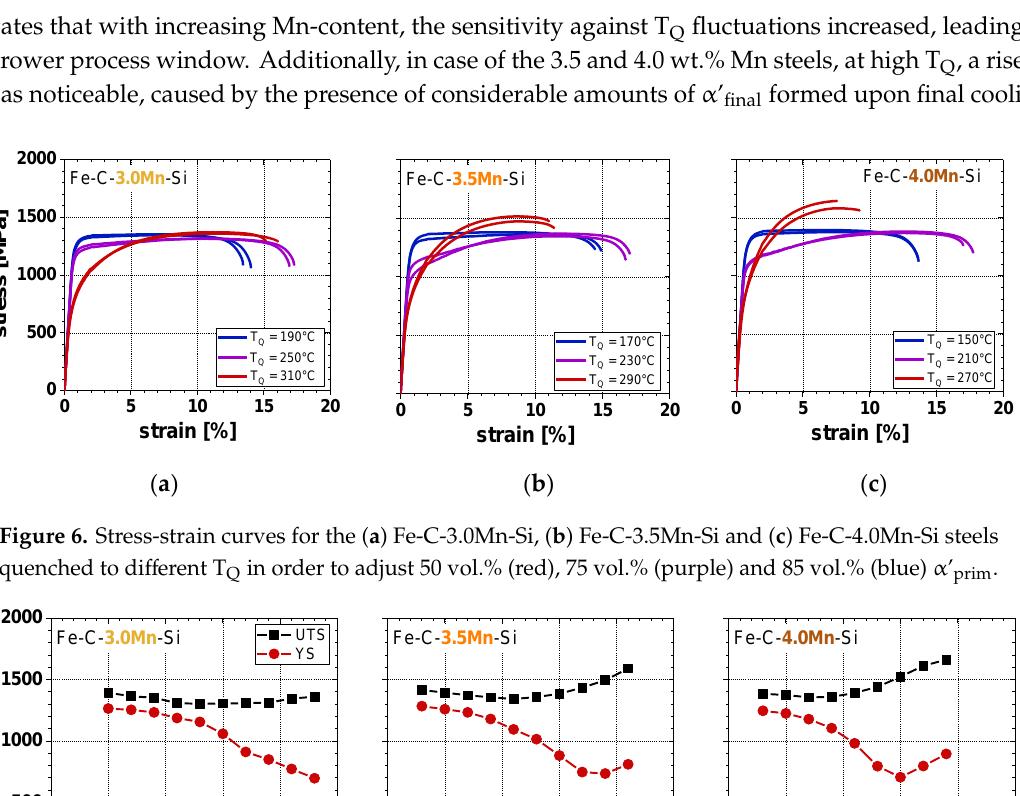
prim (blue curves) a comparable stress-